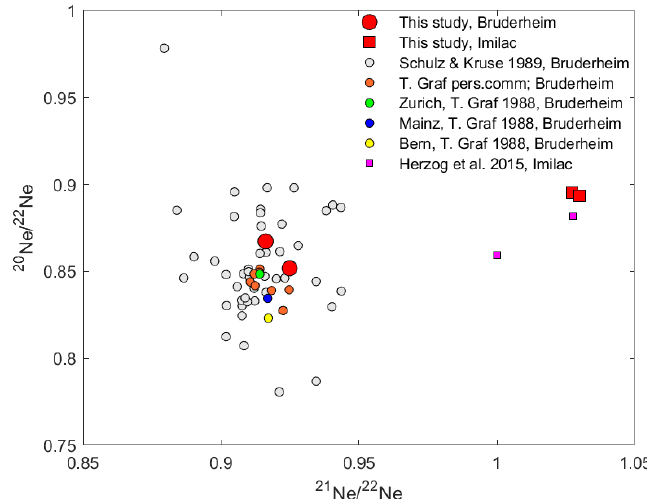
Figure 3. Neon isotopic composition of Bruderheim chondrite and Imilac pallasite analysed using ARGUS VI mass spectrometer. Bruderheim data overlapped with earlier determinations. Slight deviations in between the measurements may indicate variation in the contribution of primordial components. Imilac data overlapped with each other within the measurement error for both isotope ratios, and overlapped with earlier determinations. Measurement uncertainties are smaller than symbols. Other data are from Refs. [17–19] and personal communication with T. Graf.